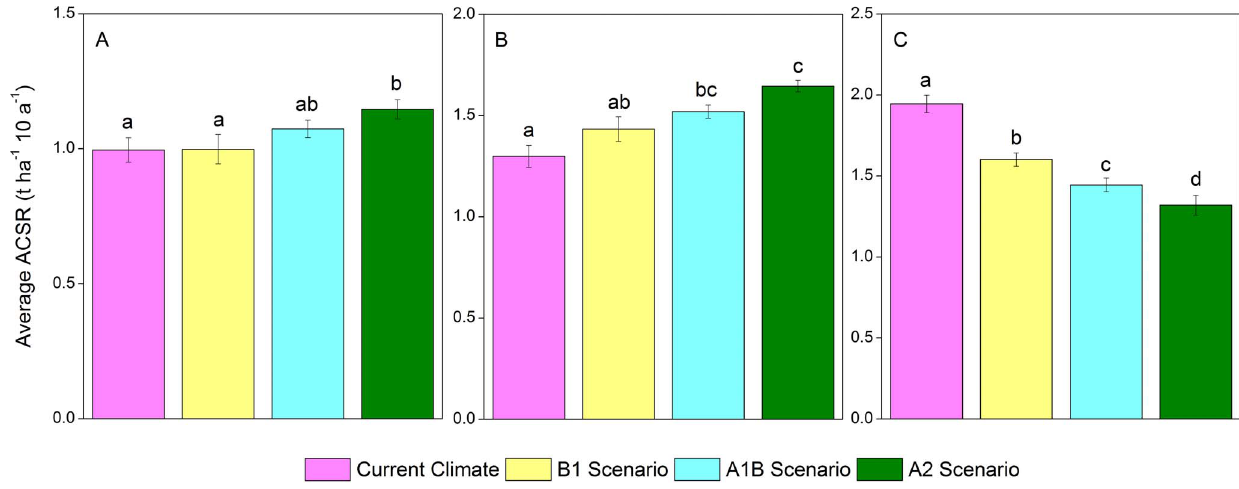
Figure 5. Results of multiple comparisons of the influences on communities’ aboveground carbon sequestration rate. A: Mixed Korean pine hardwood forests in 2060–2100, B: Mixed Korean pine hardwood forests in 2110–2150, and C: Spruce-fir forests in 2160–2200.